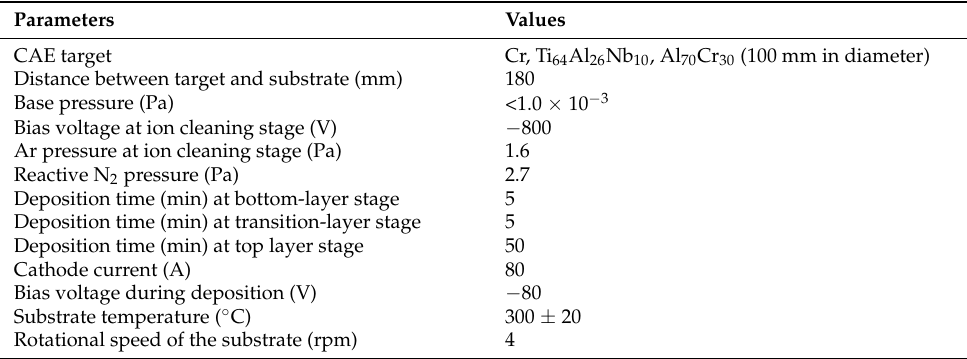
Figure 1. Schematic representation of the deposited TiAlNbN/AlCrN coatings using a cathodic arc system with multi-cathodes. Table 1. Depositing parameters of the TiAlNbN/AlCrN coatings.